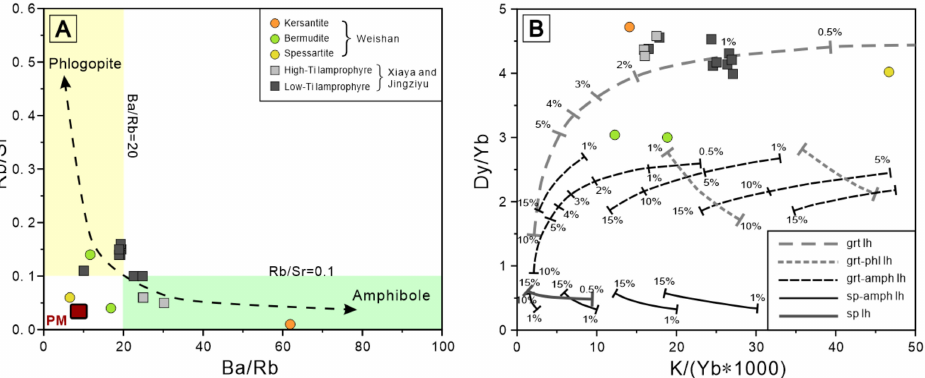
Figure 12. ( A ) Rb/Sr vs. Ba/Rb diagram. ( B ) Dy/Yb vs. K/(Yb*1000) diagram for the lamprophyres from the Weishan area